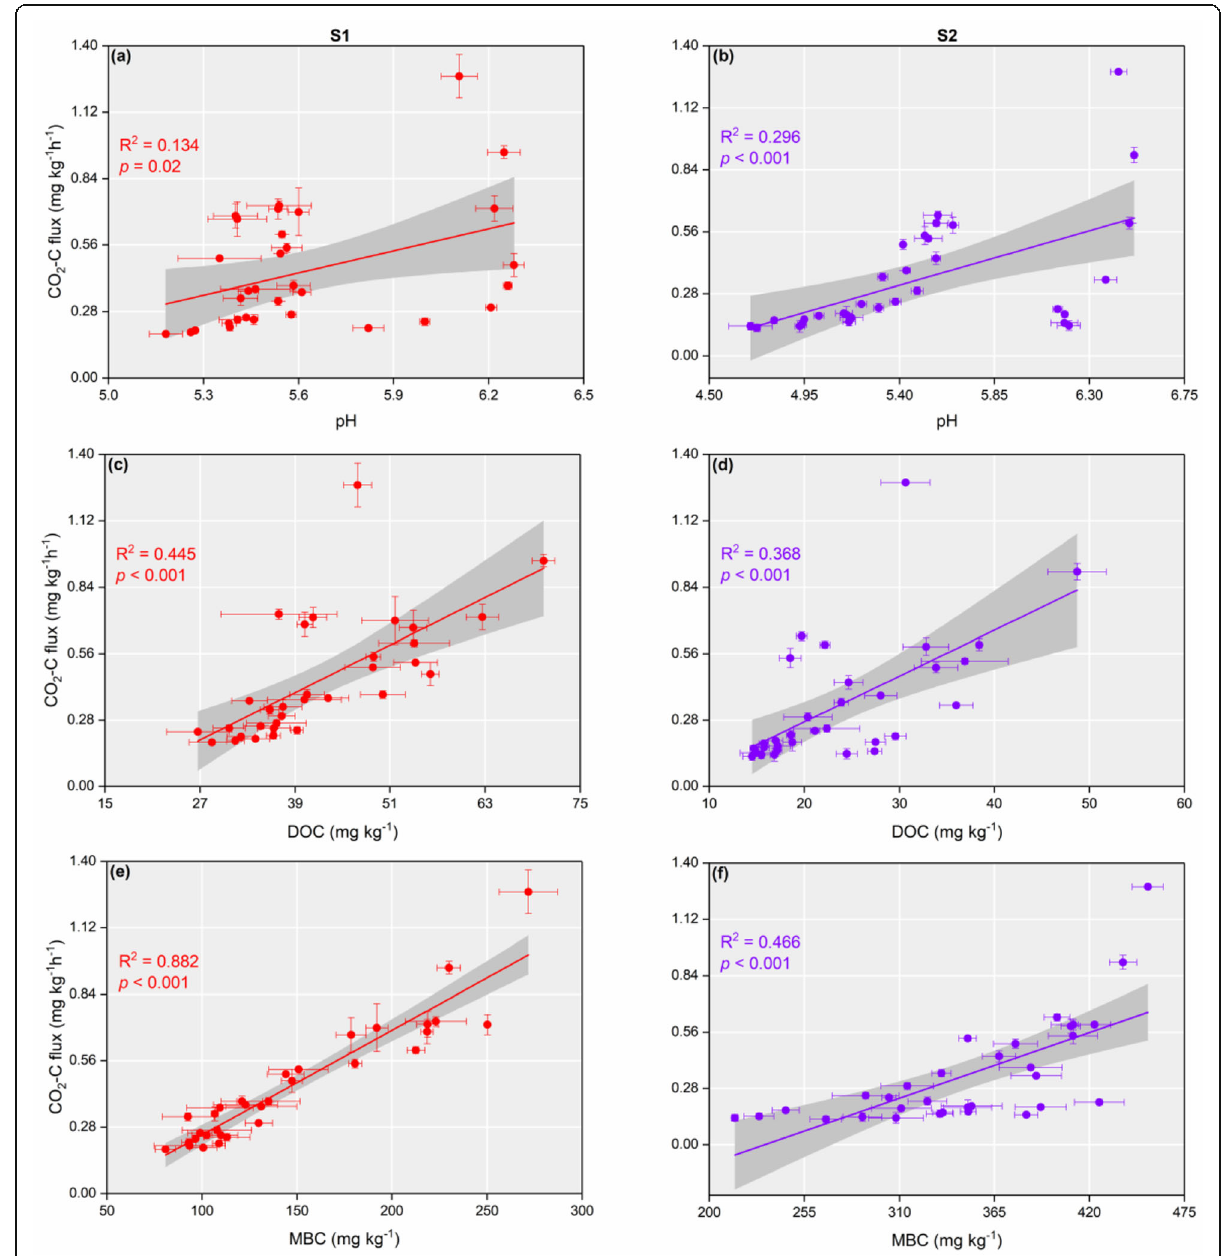
Fig. 5 Relationships between CO 2 emission flux and soil pH, dissolved organic carbon (DOC), and microbial biomass carbon (MBC) in S1 ( a , c , e ) and S2 ( b , d , f ). Shaded bands represent 95% pointwise confidence intervals. Error bars represent standard deviation of the variables ( n =